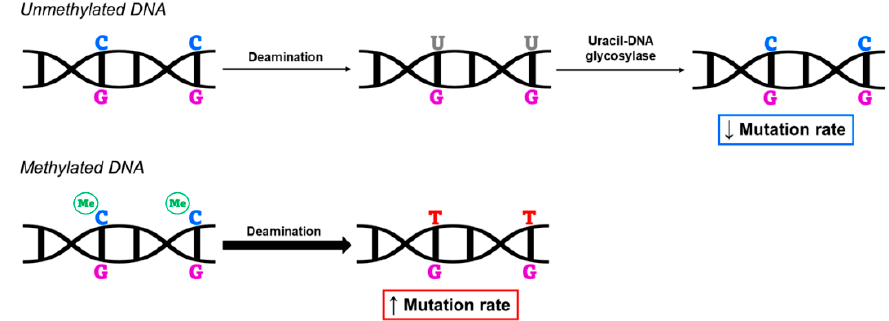
Figure 2. Schematic illustration of the difference between the deamination process of unmethylated cytosines, which are converted to uracil, and the deamination process of methylated cytosines, which are converted to thymine. The thicker arrow represents the higher conversion rate of methylated cytosines compared to unmethylated cytosines during the deamination process. The enzyme uracil-DNA glycosylase is able to eliminate uracil and promote DNA repair processes, while it is unable to eliminate thymine, causing the increased mutation rate. C = cytosine; G = guanine; U = uracil; T = thymine; Me = methyl group.